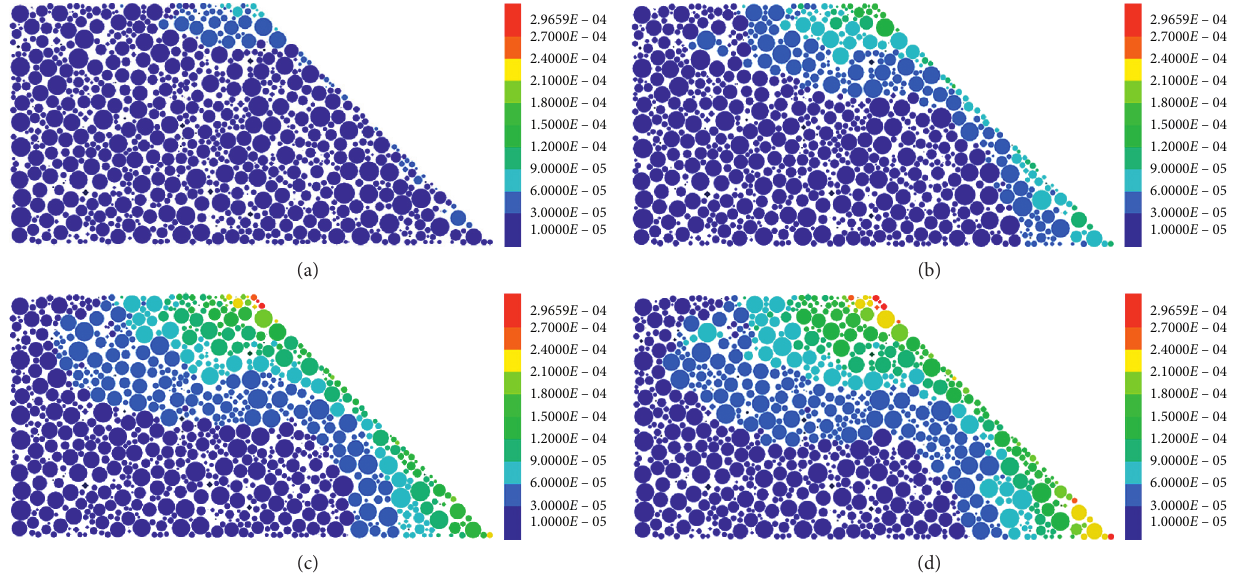
Figure 8: Horizontal displacement fields in different freezing cycles. (a) 2, (b) 4, (c) 6, and (d) 8 (unit: m).